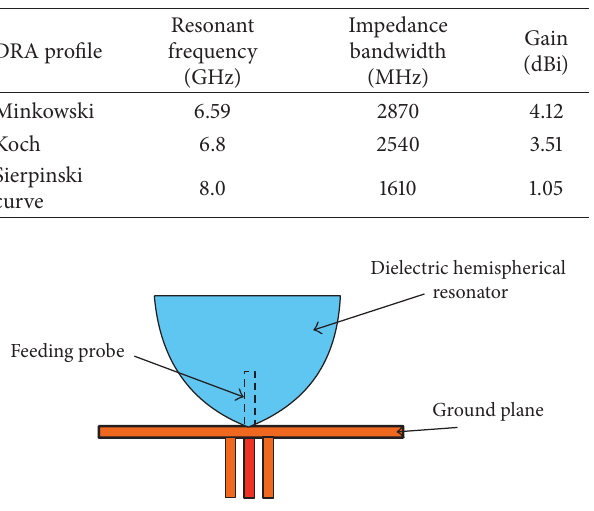
Figure 22: Cup-shaped inverted hemispherical DRA as suggested in [51] for impedance bandwidth